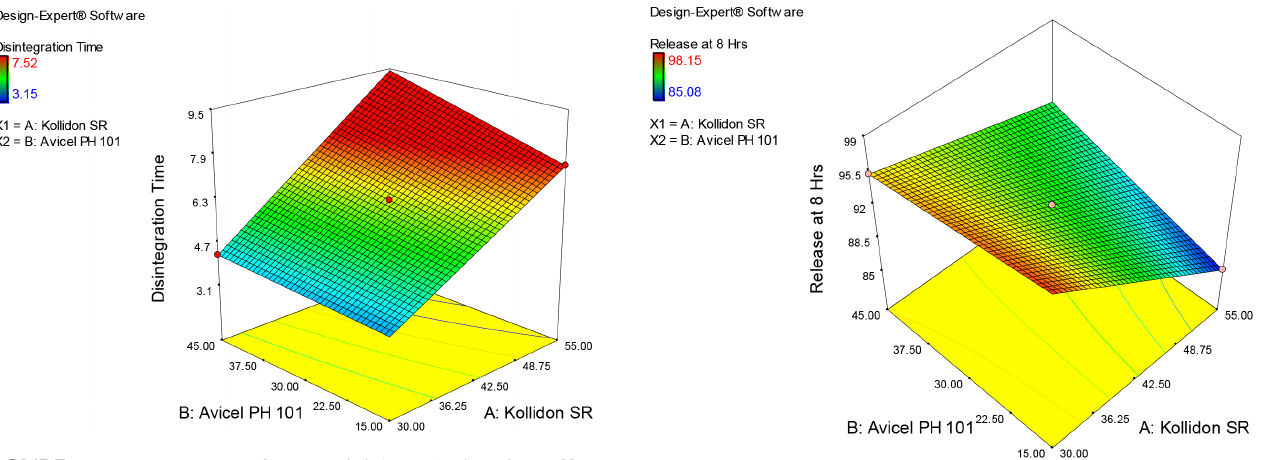
FIGURE 8a - Response surface model (RSM) showing effect of independent variables Kollidon SR and Avicel pH 101 on Disintegration time.